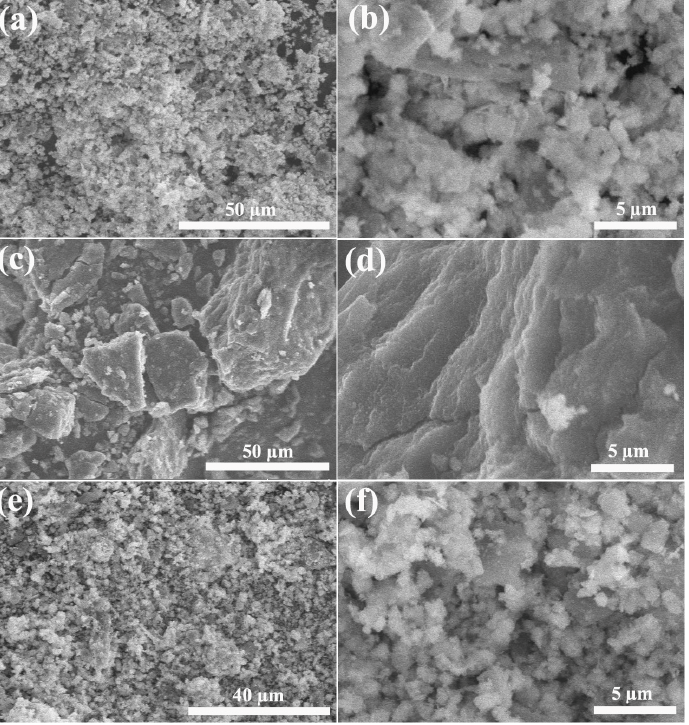
Figure 3. SEM images of BiOCl-BiPO 4 ( a , b ), PDI ( c , d ) and PDI(5%)/BiOCl-BiPO 4 ( e , f ).